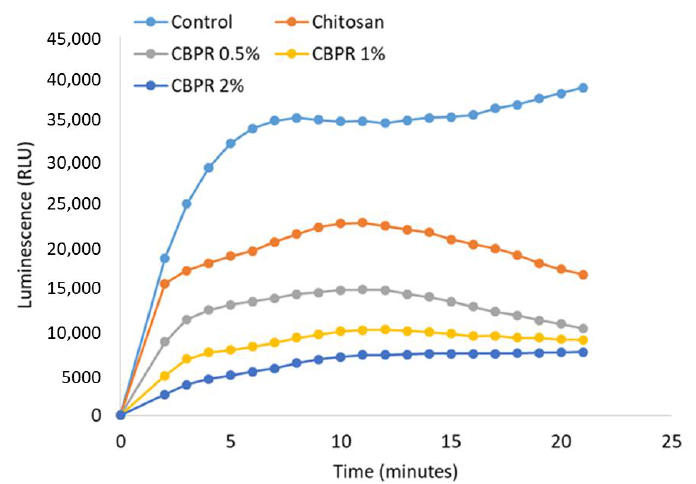
Figure 14. Antioxidant activity of different chitosan/BPE films on ROS production in human neutrophils. Results are expressed as RLU (relative luminescence units). The results are expressed as mean ± SD of the measurements made under the microscope (n = 6) carried out in two individual experiments.